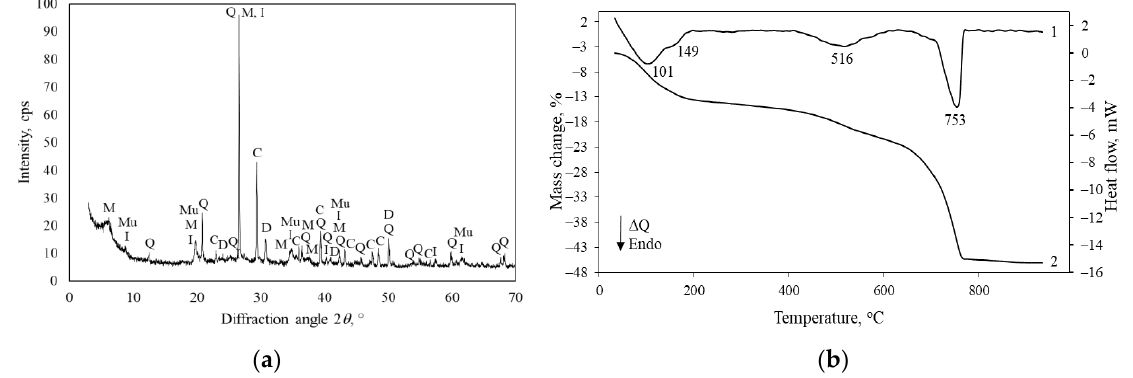
Figure 4. XRD pattern ( a ) and STA curves ( b ; 1—DSC, 2—TG) of Saltiskiai clay. Indexes: C—calcite, D—dolomite, Q—quartz, I—illite, M—montmorillonite, Ms—muscovite.